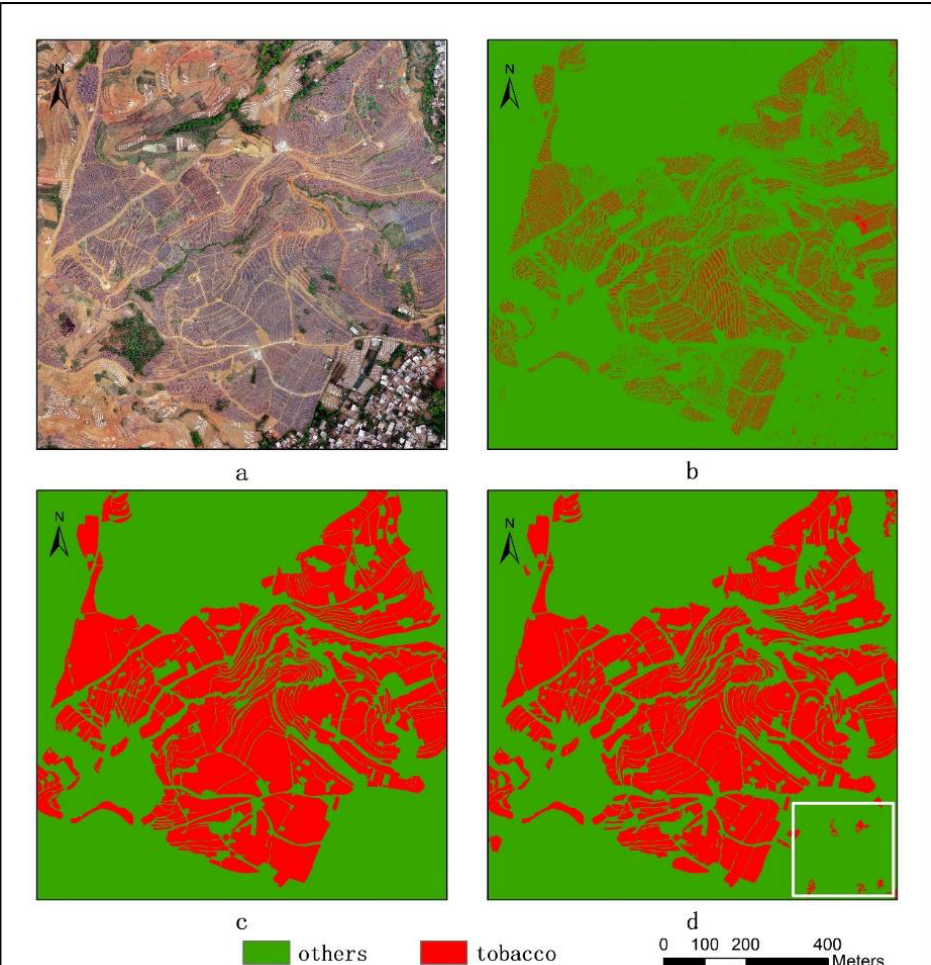
Figure 5. Comparison of the classification results (( a ) aerial image; ( b ) binary map by recoding the maximum likelihood classification result; ( c ) tobacco distribution map by visual interpretation; ( d ) tobacco distribution map by using the proposed method).